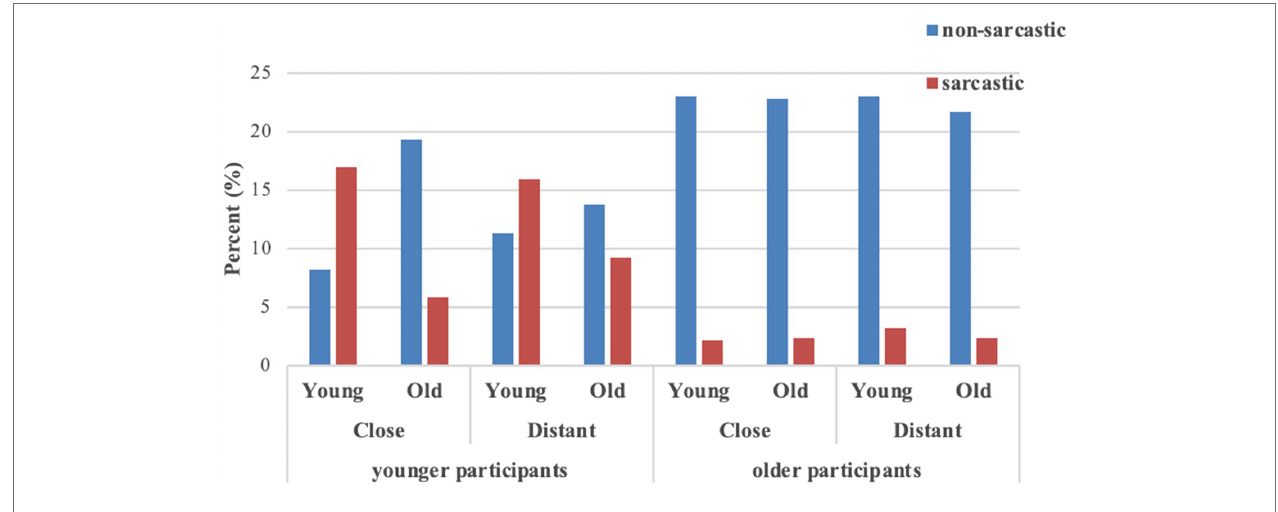
FIGURE 1 | Frequencies of sarcasm in Experiment